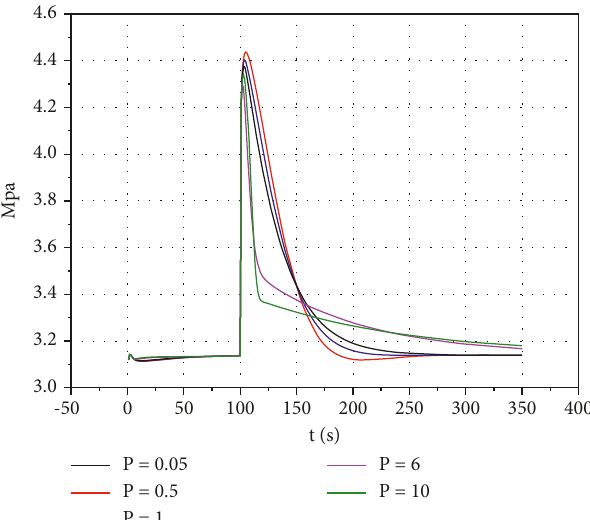
Figure 4: The changes of pressure at different P when I and D are